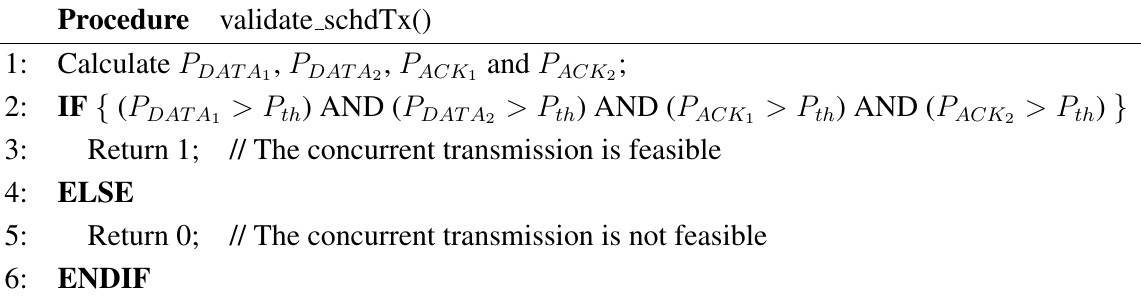
Table 1. The validation procedure for feasibility of a concurrent